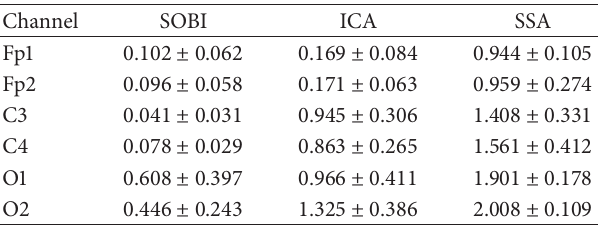
Table 1: MI by different EOG artifact correction methods over 20 artificially contaminated EEG data